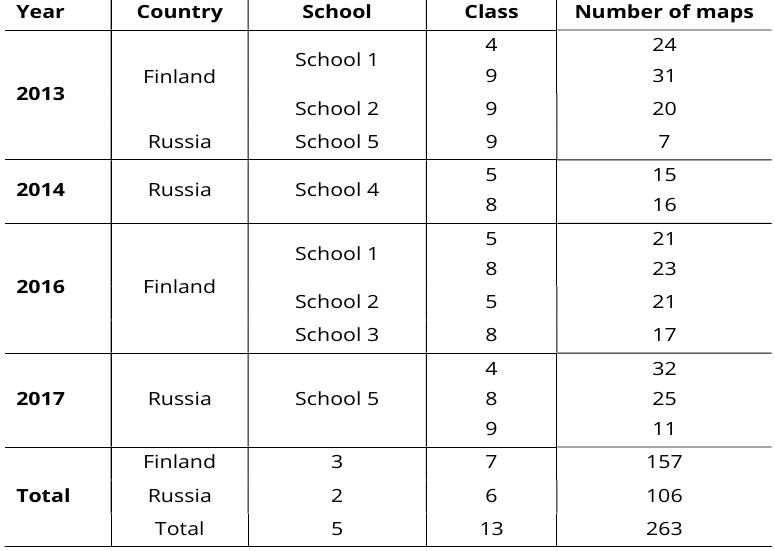
Table 1 . The mental maps by year, country, school, class and